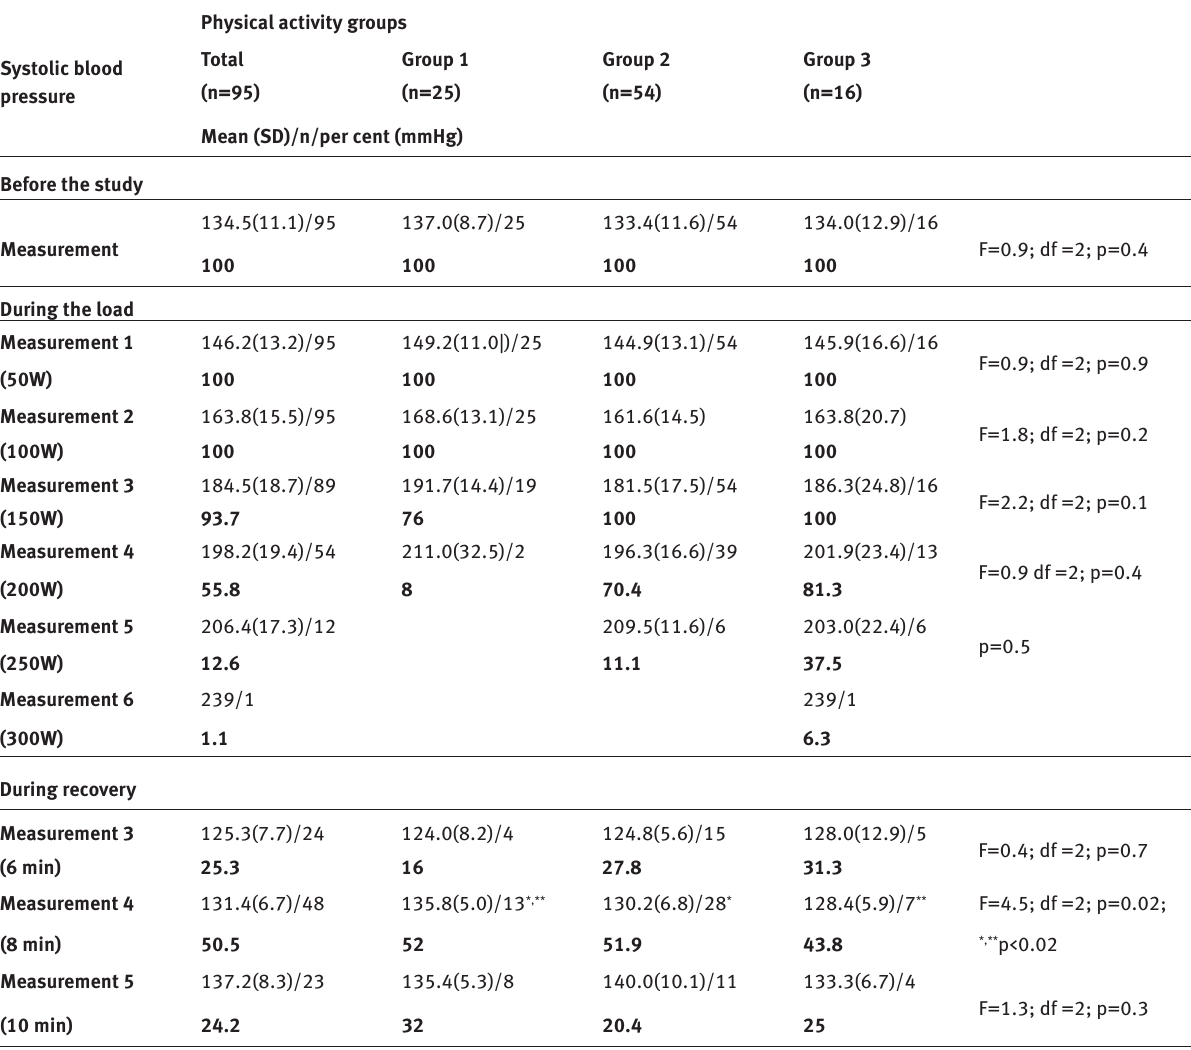
Table 3: Systolic blood pressure in subjects before the study and its changes during physical load and recovery time taking into account physical activity groups